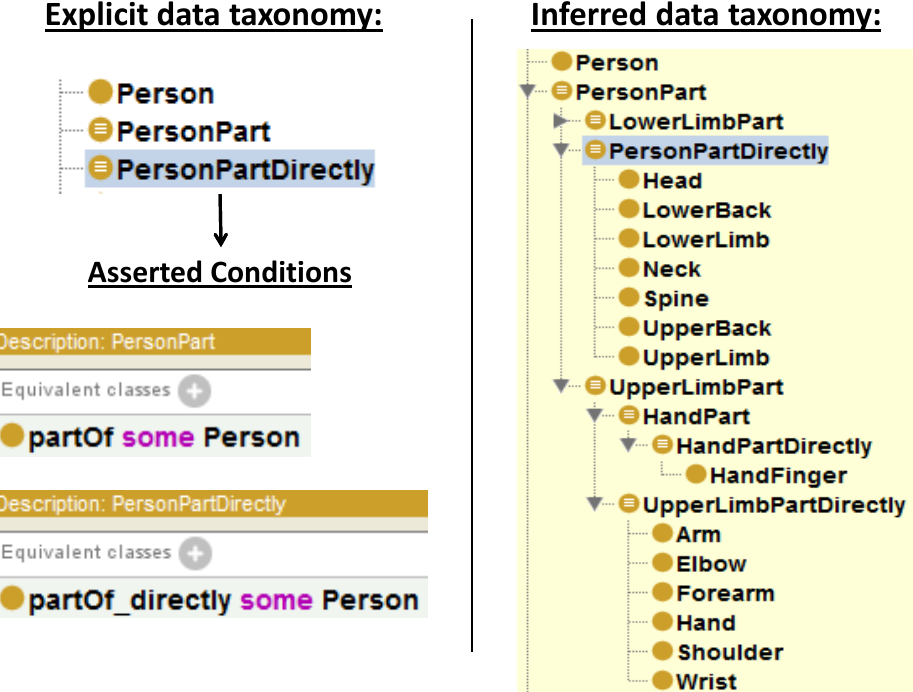
Figure 5. An example of explicit and inferred